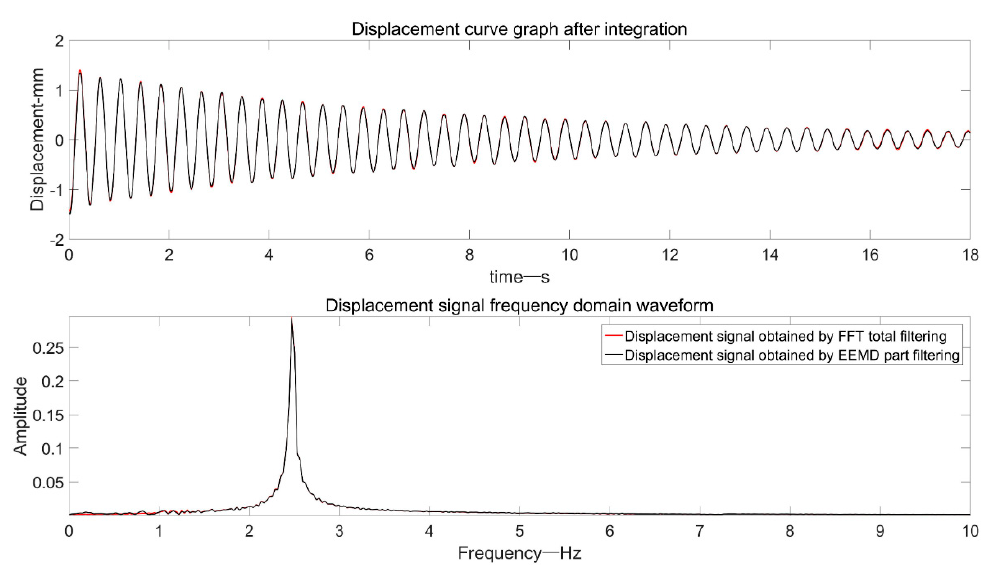
Figure 21. Comparison of “ideal signal” and intercepted signal based on EEMD filtering.